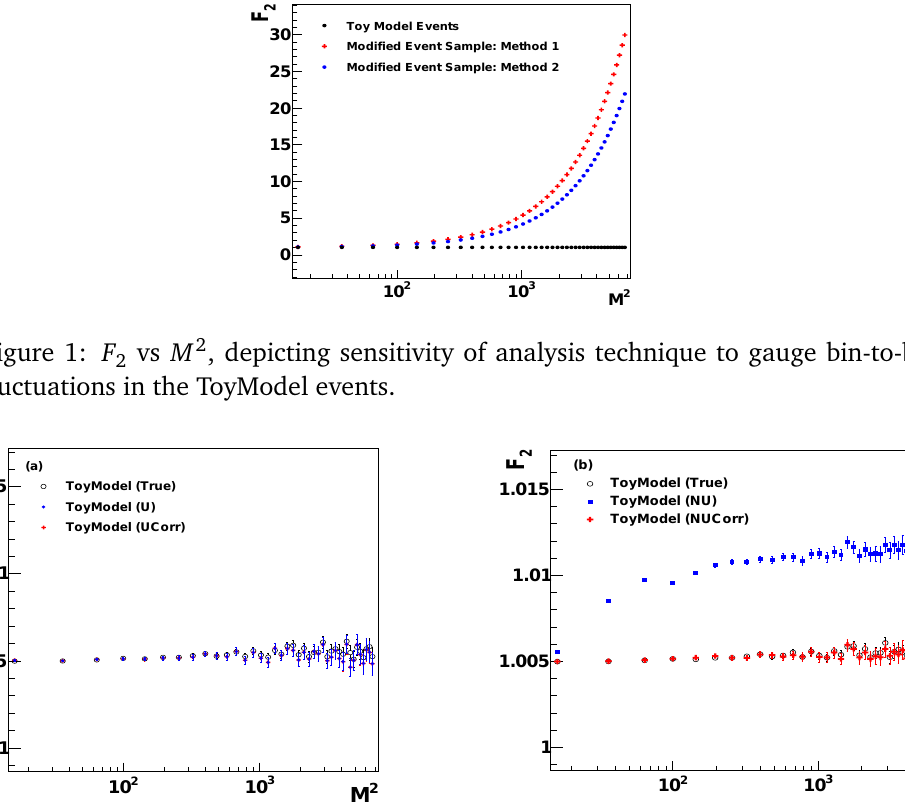
Figure 2: F vs M 2 plot in case of (a)binomial type efficiencies and (b)non-binomial 2 type